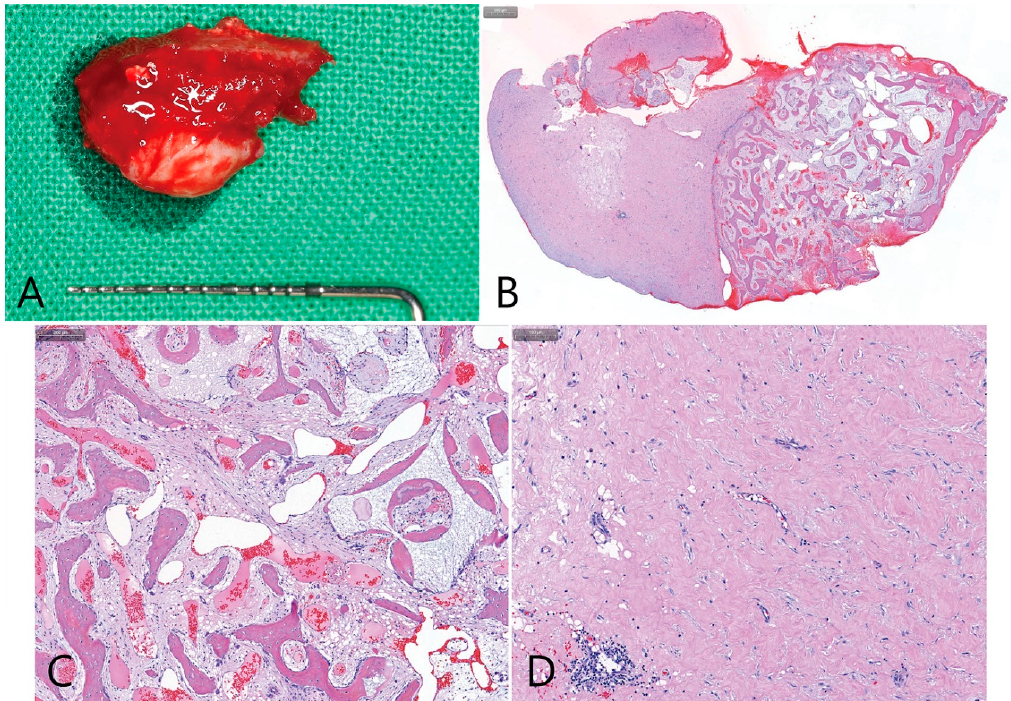
Figure 12. ( A ) The removed specimen was fixed in 10% formalin solution for histopathological examination; ( B ) the specimen was examined after hematoxylin and eosin (H&E) staining. Newly formed bone and void tissue were clearly bordered; ( C ) new bone formation was found around the bone graft particles, and osteoblasts, osteocytes, and osteoclasts were observed; ( D ) no new bone formation was observed in the void area. Epithelial cells containing cilia were not observed in the void tissue which consisted only of dense connective tissue.